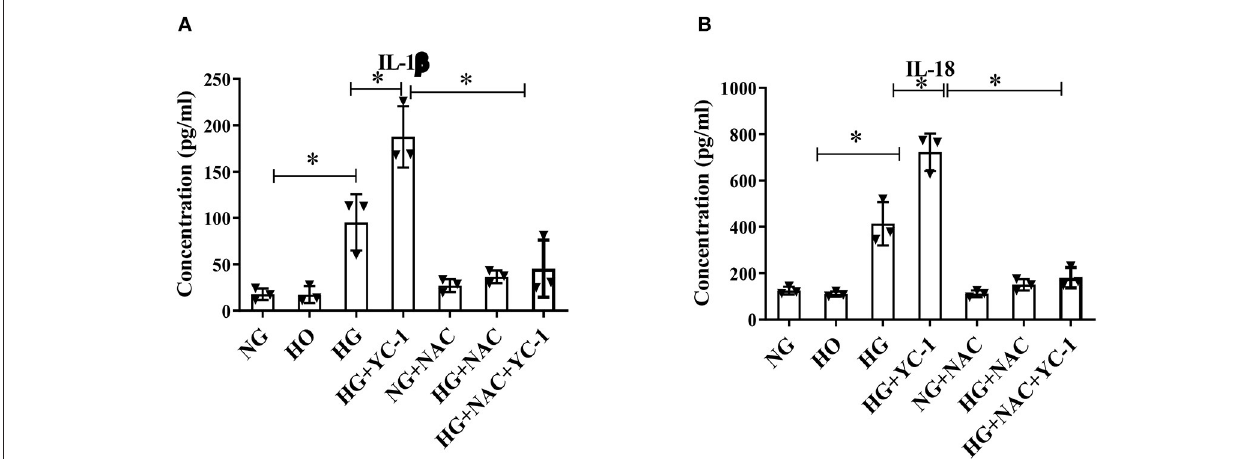
FIGURE 4 | Inhibition of HIF-1 α significantly promoted the degree of HG-induced inflammation. (A,B) . Inflammatory cytokines IL-1 β and IL-18 in HK-2 cells subjected to HG exposure were quantitatively measured by ELISA. The cytokine levels were further increased with YC- 1 and reversed with NAC. * p < 0.05. vs. indicated group.